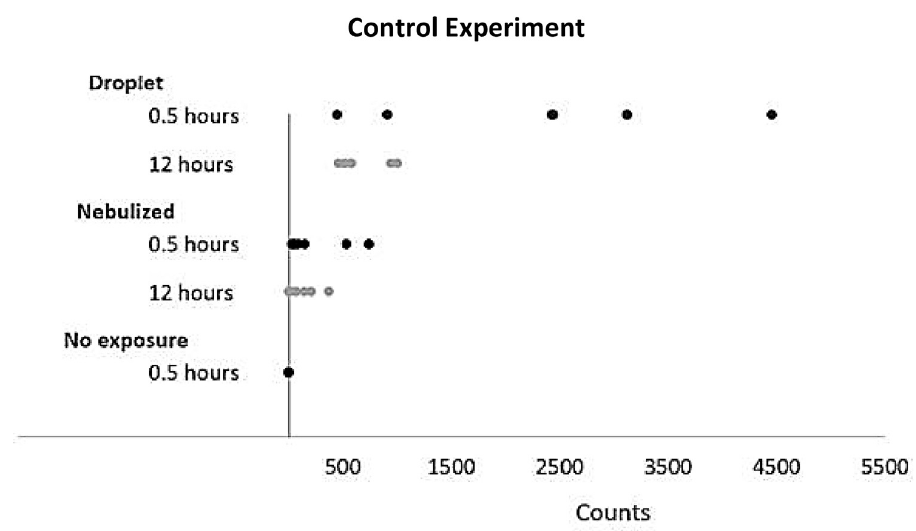
Fig 3. Control experiment. Inactivated SARS-CoV-2 was nebulized to simulate aerosol events or placed by pipette to simulate droplet events to determine absorption and recovery from brown paper bag swatches and compared with samples without exposure. (Counts = total viral counts recovered on